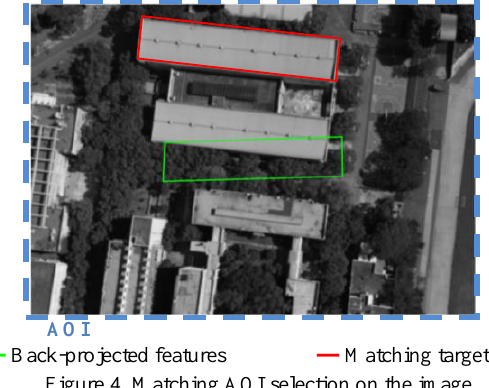
Figure 4. Matching AOI selection on the image